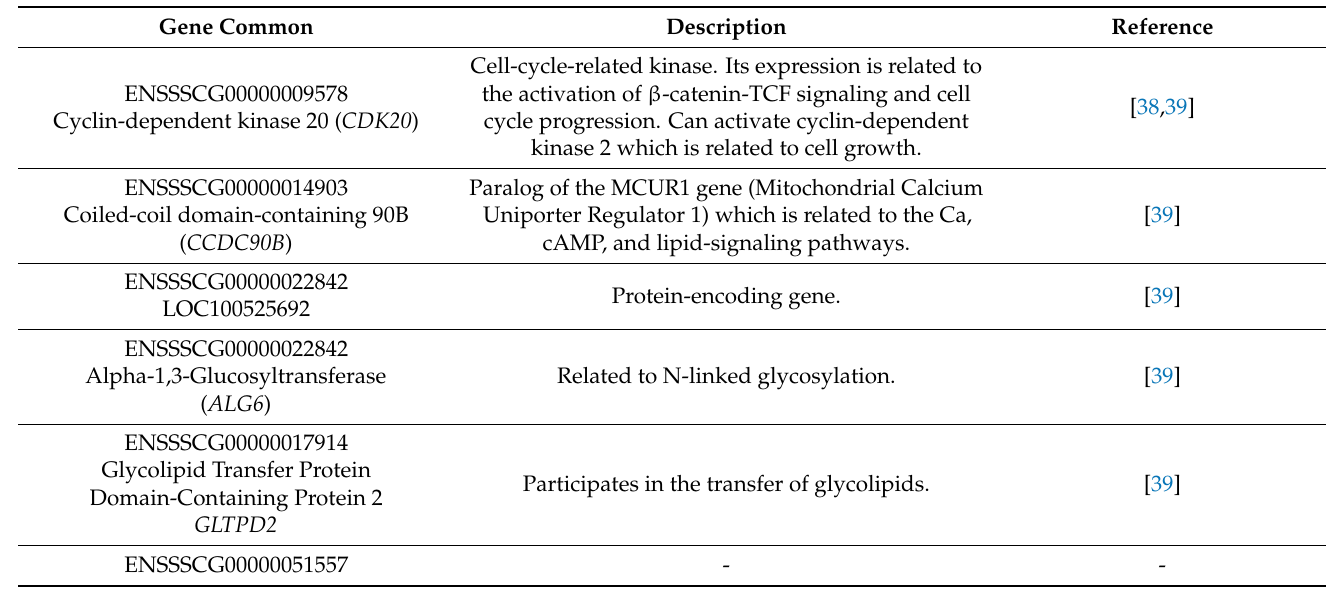
Table 3. Common differentially expressed genes between the two tissues comparisons, in the skeletal muscle and liver tissue of pigs fed with two different levels of soybean oil in the diet (1.5% and 3.0% of soybean oil).